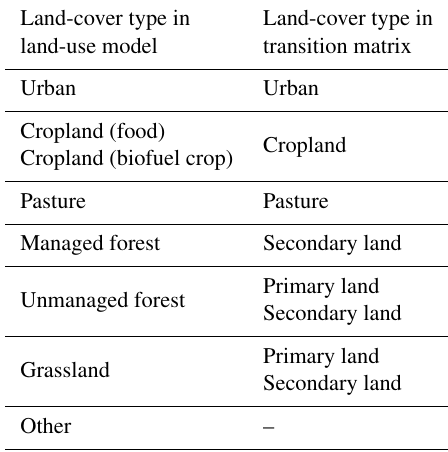
Table B1. Correspondence of land-cover type in land-use model and transition matrix.